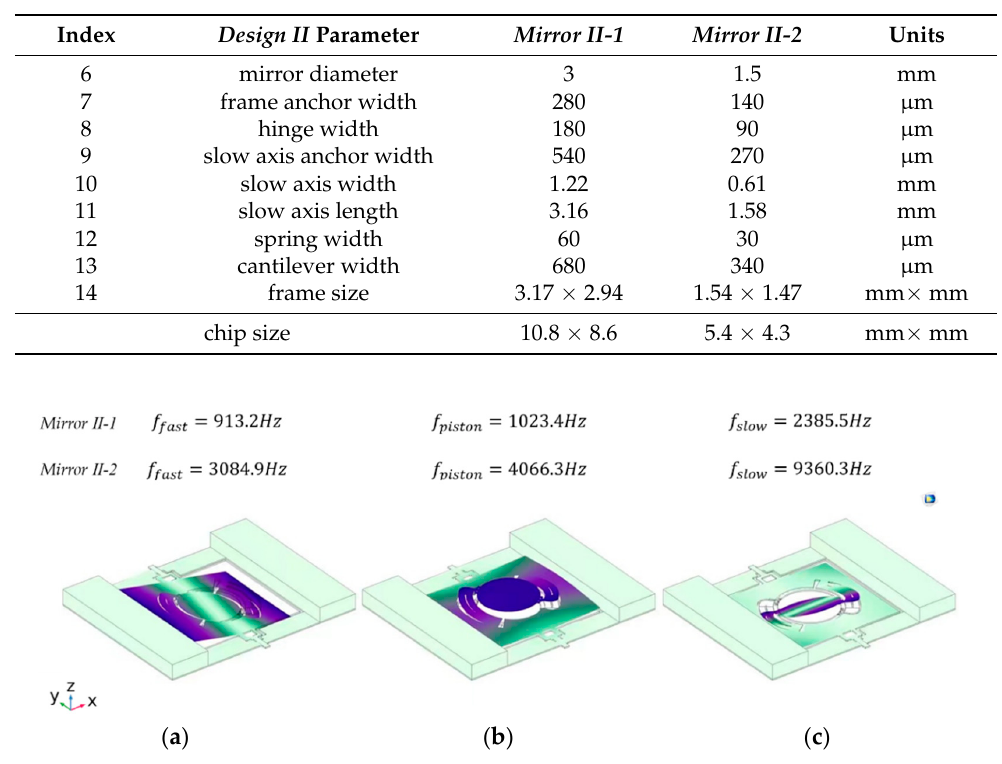
Figure 4. The mode shape results of Design II : ( a ) the first mode of the mirror is the torsion mode of the slow axis; ( b ) the second mode is piston mode, with the frame piston along the z-axis; ( c ) the fast axis resonates with high frequencies, which offers a significant difference between the two torsion modes.